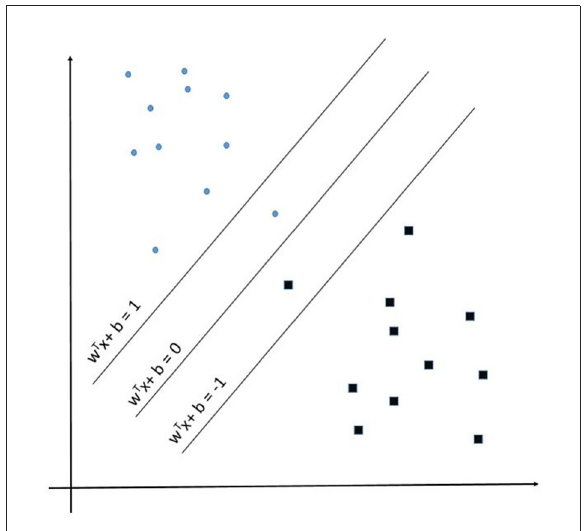
FIGURE3 Support Vector Machine example representation showing the maximum-margin hyperplane W T x